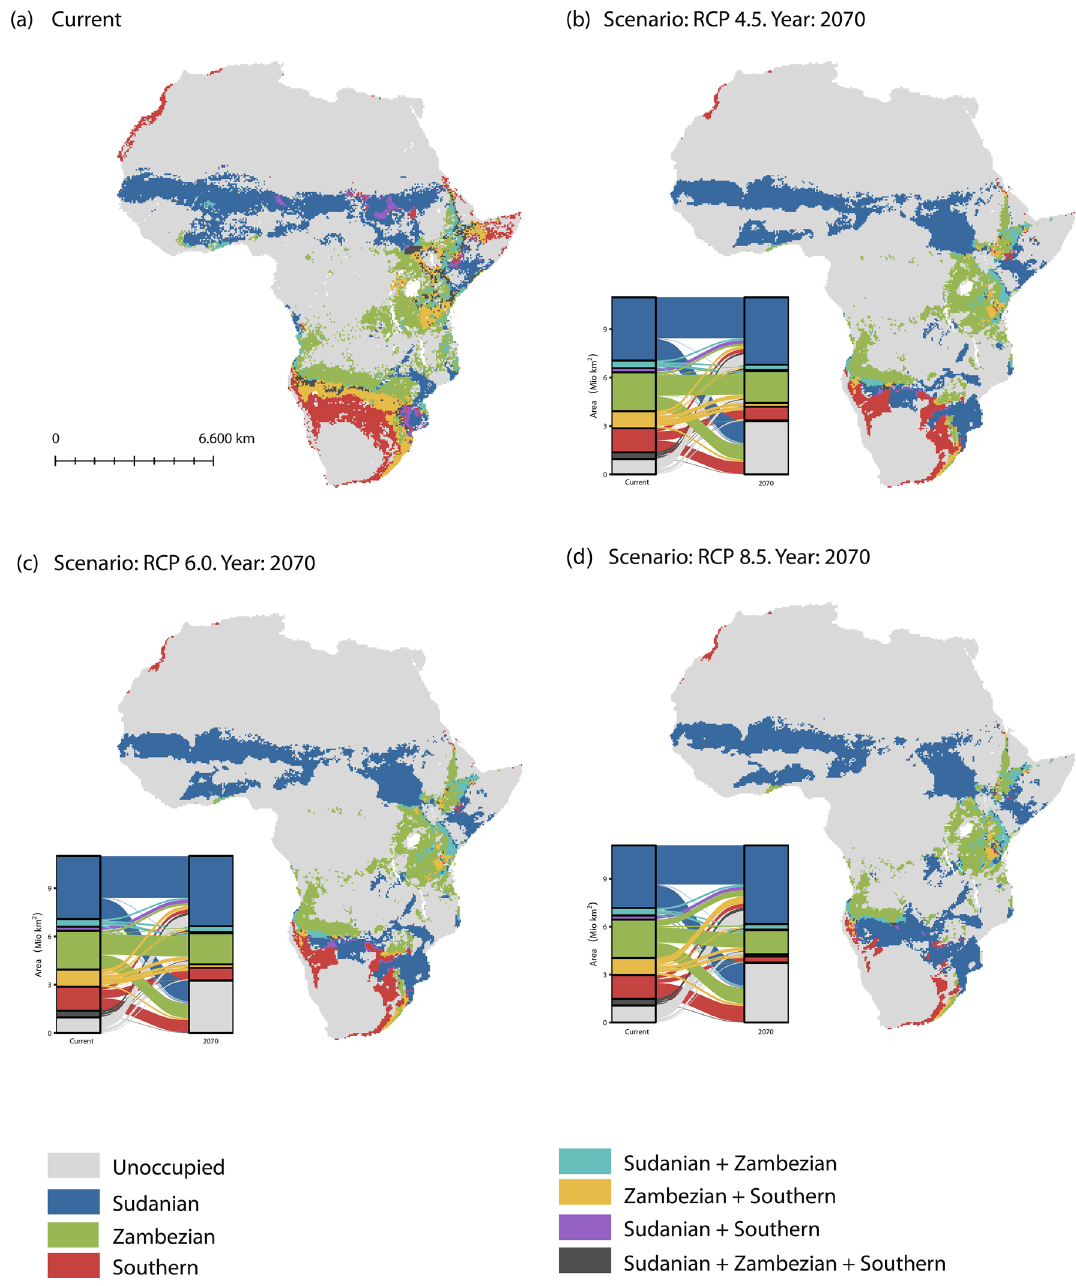
Figure 5. Potential current and future (2070) distribution of three phylogeographic groups of Senegalia senegal (Sudano-Sahelian, Zambezian and Southern) in Africa according to Biomod2 distribution modelling. ( a ) Present-day suitability; ( b ) intermediate emission RCP 4.5 scenario; ( c ) high emission RCP 6.0 scenario and ( d ) very high emission RCP 8.5 scenario projected with CCSM4 model. Inset ( b – d ) are Sankey plots showing how the area occupied by the phylogroups will change for three climate change scenarios. The shape files for the maps were downloaded from WORLDCLIM 41 . The modeled potential future distribution of S. senegal were generated using ArcGIS Desktop ver. 10.5 42